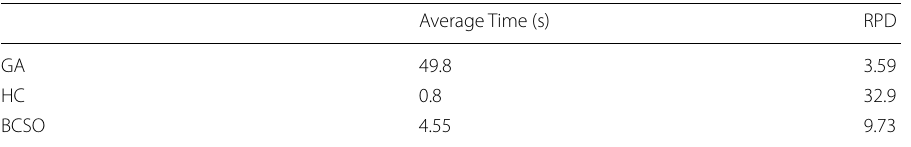
Table 6 BCSO Comparison to GA and